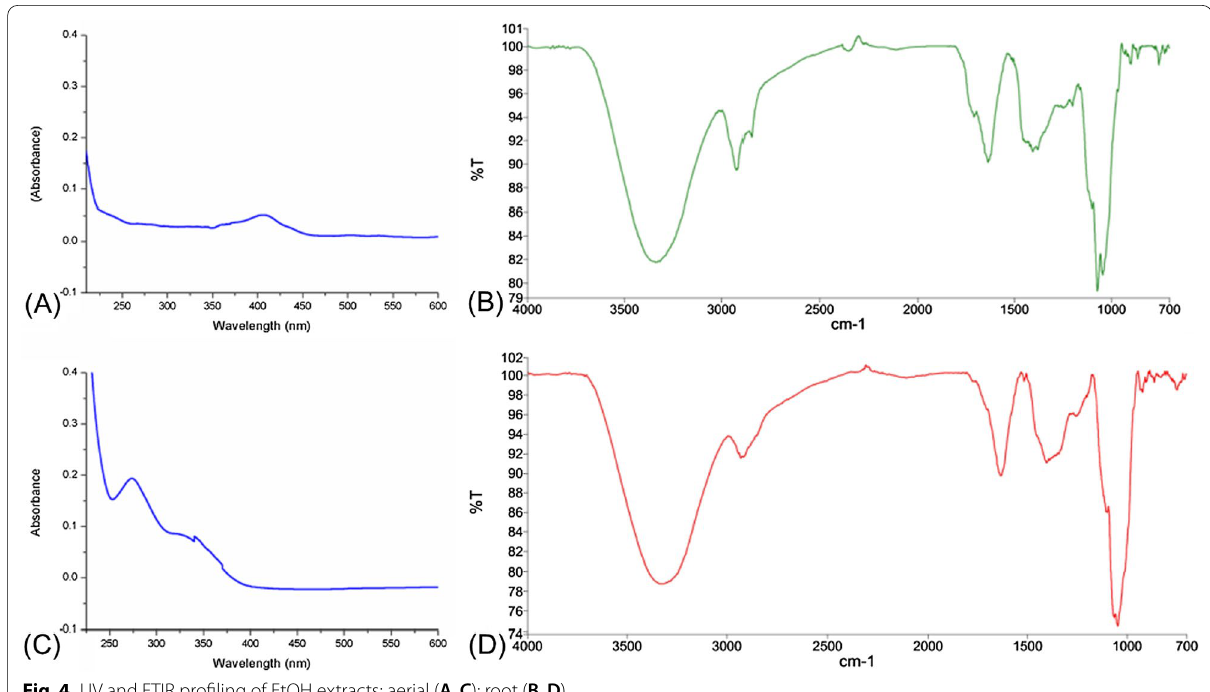
Fig. 4 UV and FTIR profiling of EtOH extracts; aerial ( A , C ); root ( B , D )